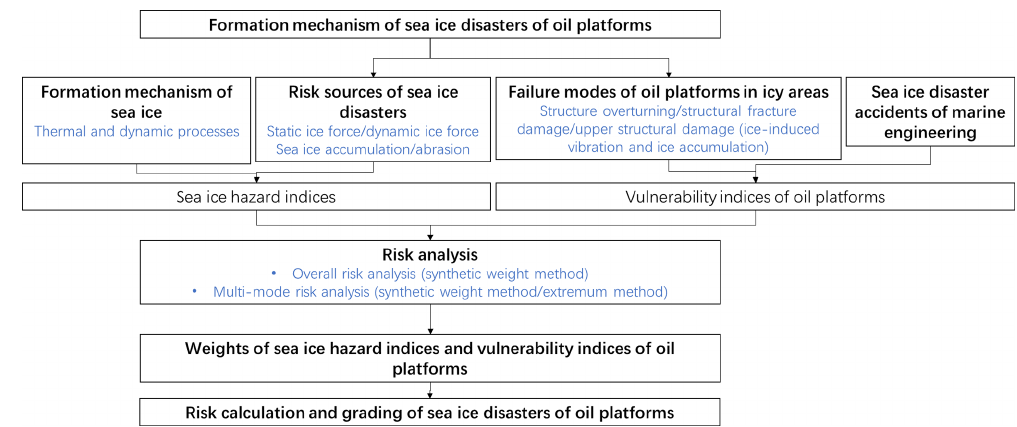
Figure 3. Flow chart of risk assessment of sea ice disasters on oil